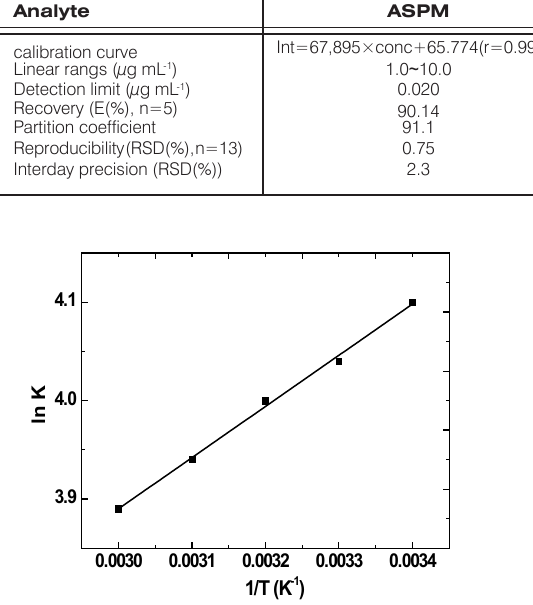
Figure 6. Vant Hoff plot. Effect of temperature on the partition equilibrium of